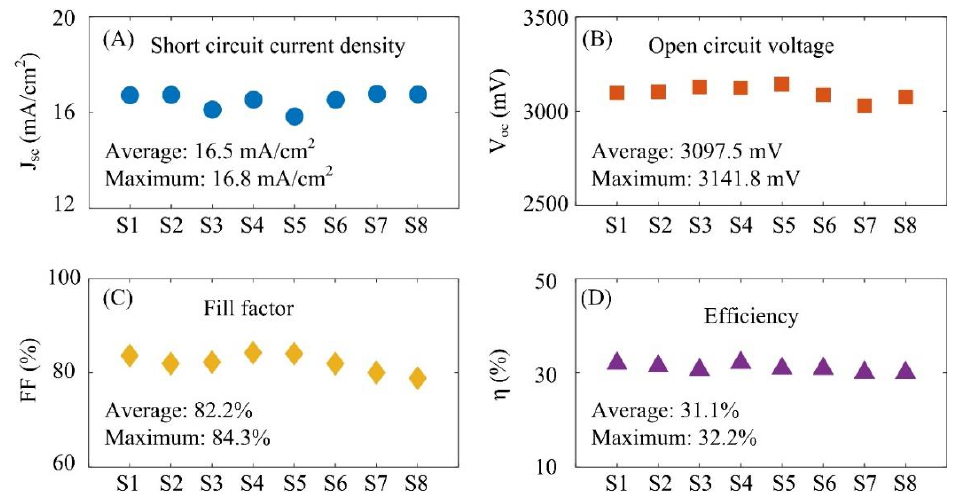
Figure 3. The ( A ) J sc , ( B ) V oc , ( C ) FF and ( D ) η of the eight samples (S1–S8) at the beginning of life. The average and maximum J sc , V oc , FF and η are marked in each figure.